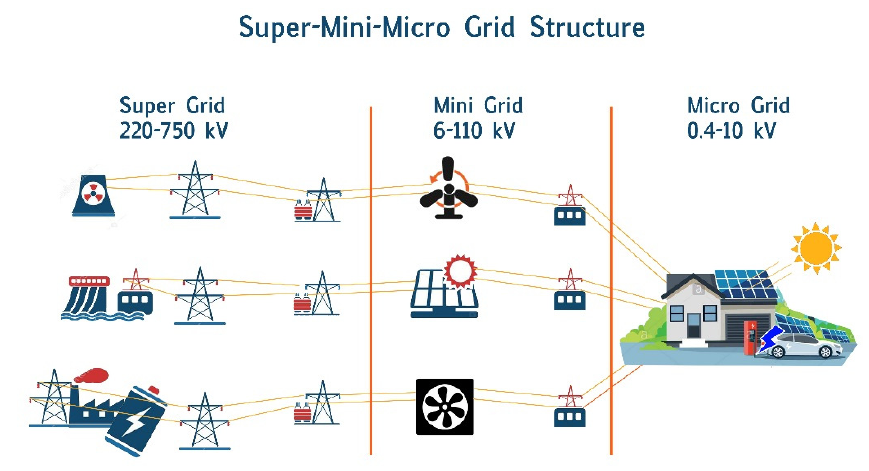
Figure 1. Three-level structure of future electric power systems [4].